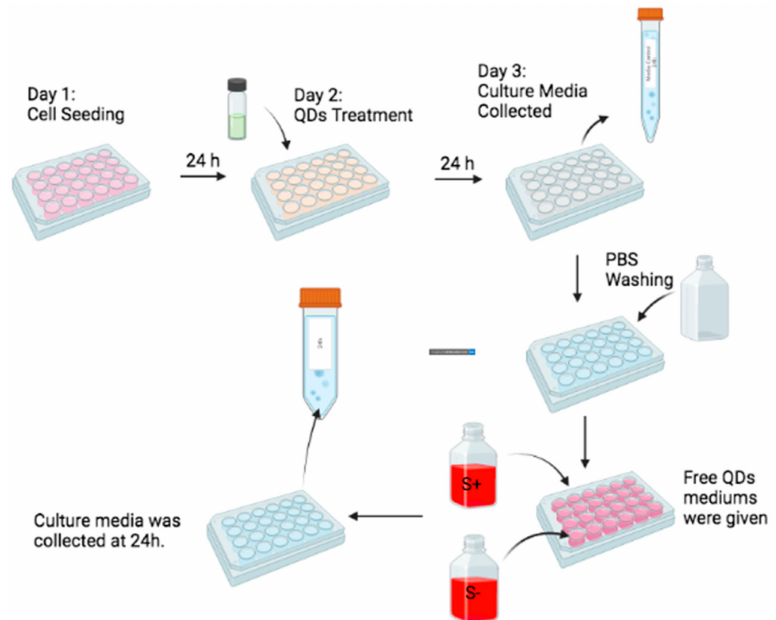
Figure 11. A figure illustrating the ICP-OES method for quantifying the amount of internalized and released QDs under different treatment conditions: 50 µ g/mL of green CdSe/ZnS QDs with or without serum as well as cells with 100 µ g/mL cultured in serum − media for 24